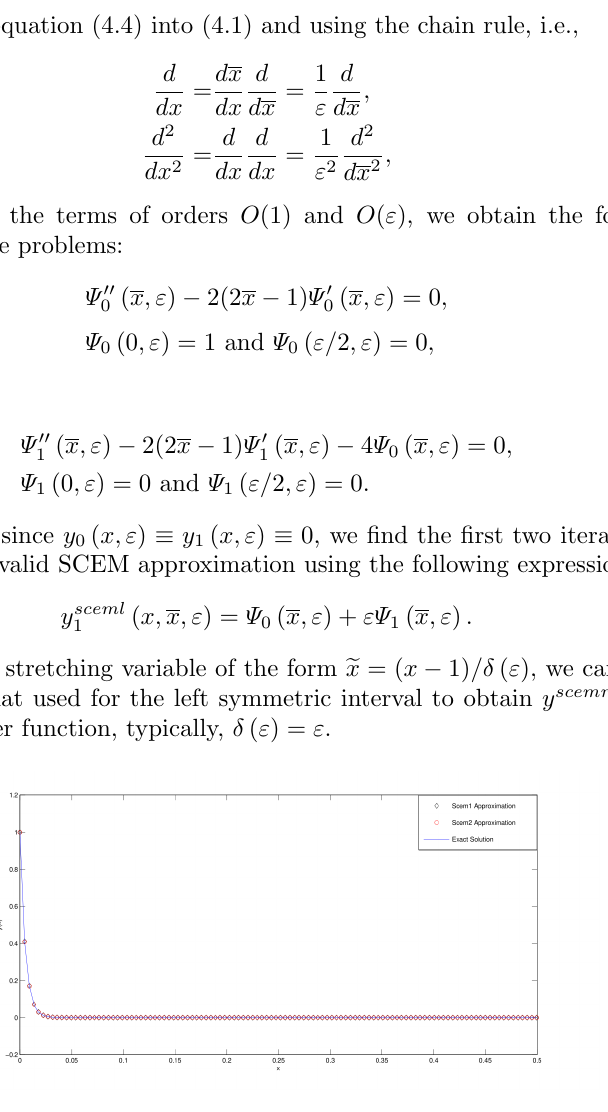
Figure 1. Comparison of the analytical solution and SCEM approximations in solving left symmetric problem for Equations (4.1)–(4.2); ε = 0 . 01. The exact solution and SCEM approximations are almost